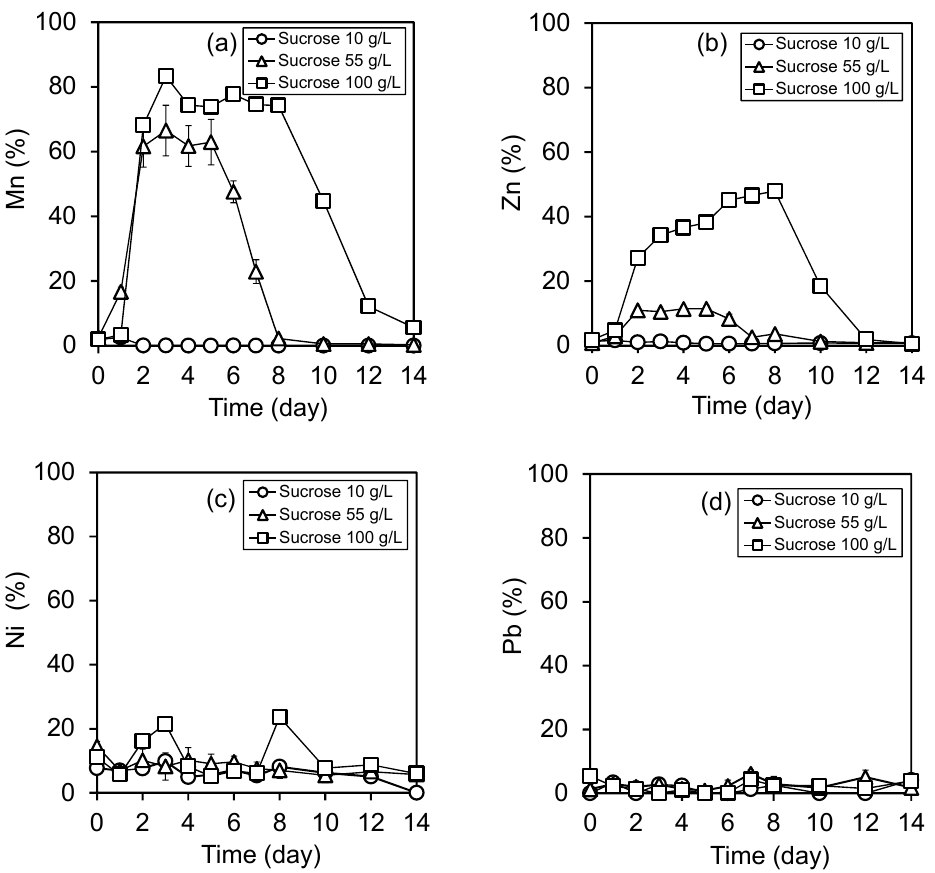
Figure 4. Effects of sucrose concentration on the metal solubilization during the fungal bioleaching experiments ( a ) Mn, ( b ) Zn, ( c ) Ni and ( d ) Pb. Table 2. Correlation coefficients between metal removal efficiency and organic acids.